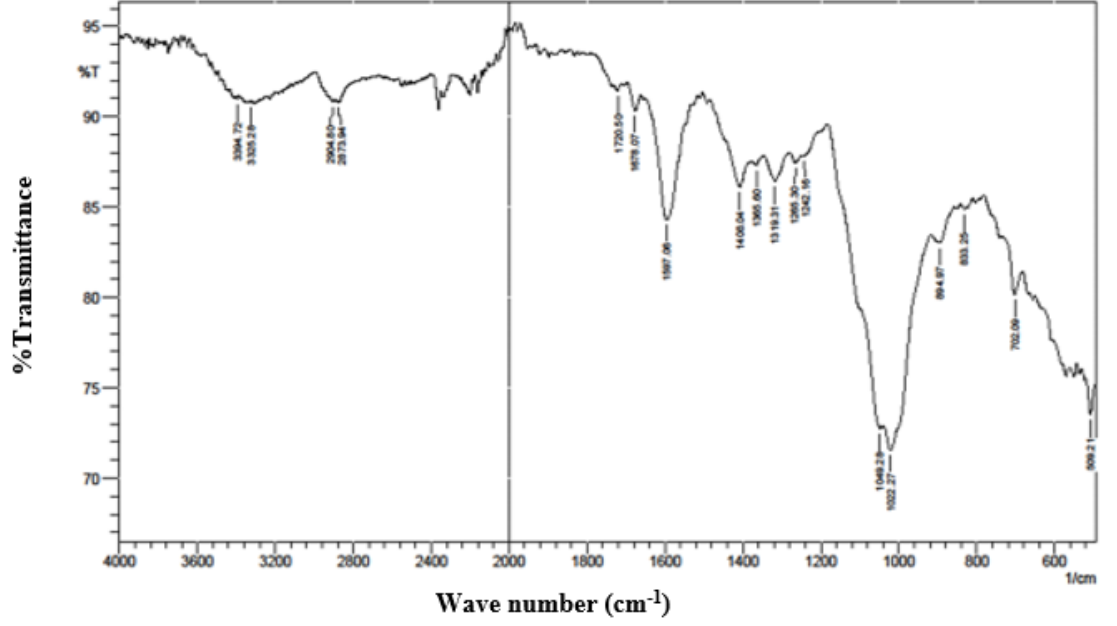
Figure 7. FTIR spectrum of SSD16 Powder X-ray diffraction (PXRD)